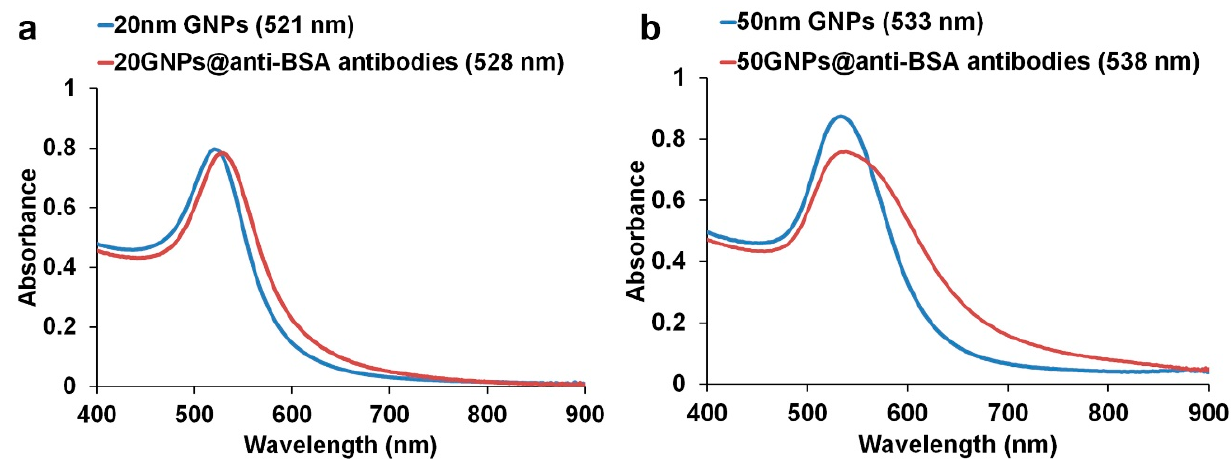
Figure 4. Comparison of the light absorption spectra of ( a ) 20 nm GNPs and ( b ) 50 nm GNPs before and after conjugation with anti-BSA antibodies.